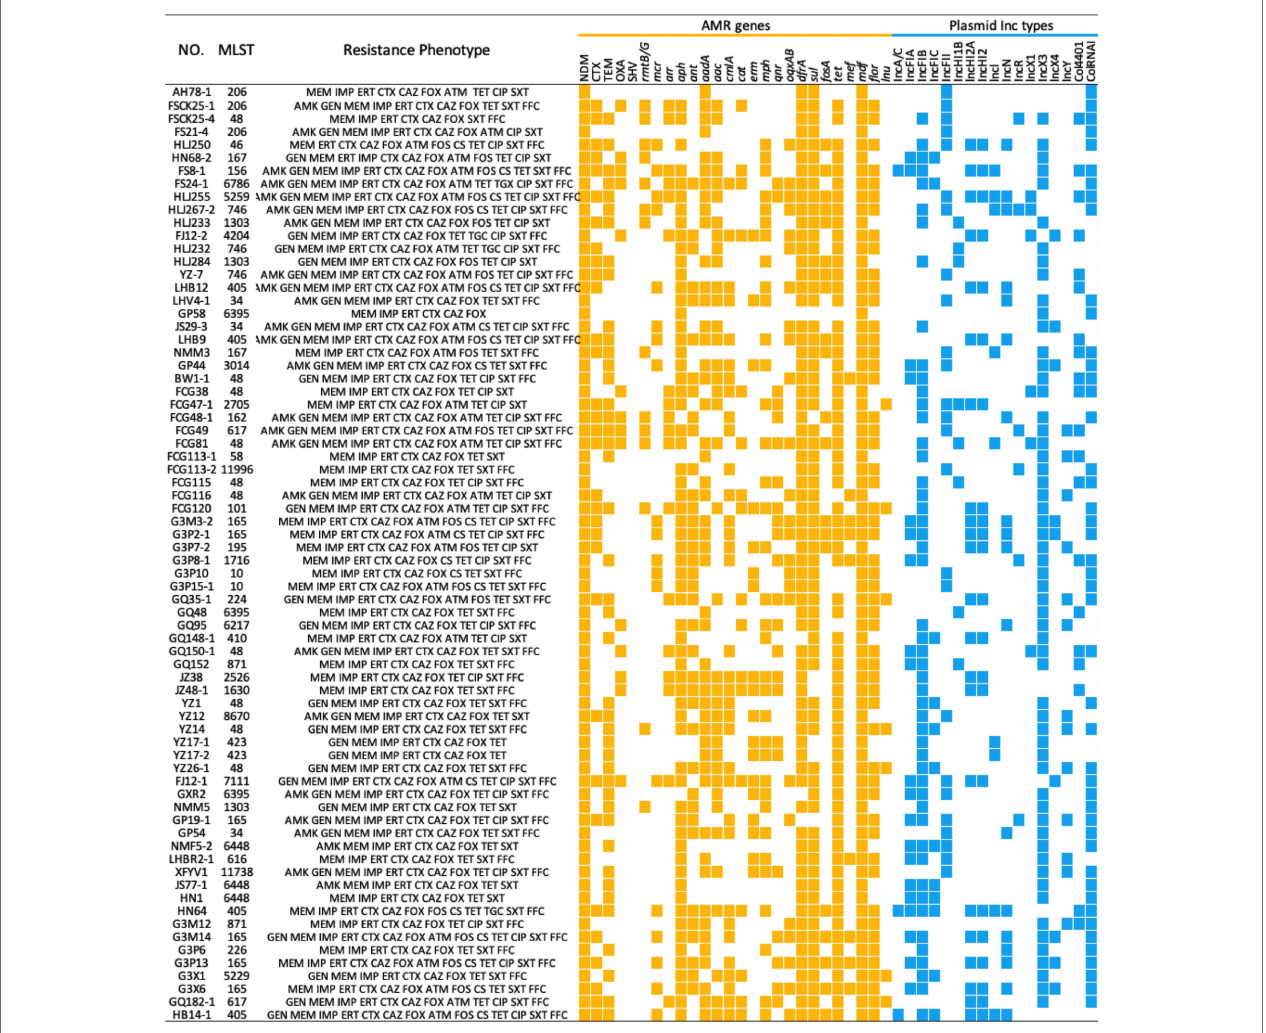
FIGURE 2 | MLST, Resistance Phenotype, ARG and plasmid replicons of 72 NDM-positive Escherichia coli isolates from food-producing animals in China. The heatmap was generated after aligning the contigs of sequenced genomes of each strain to MLST, Resfinder and PlasmidFinder. ARGs and plasmid Inc. types are indicated by yellow and blue squares, respectively. AMK, amikacin; GEN, gentamicin; MEM, meropenem; IMP, imipenem; ERT, ertapenem; CTX, cefotaxime; CAZ, ceftazidime; FOX, cefoxitin; ATM, aztreonam; FOS, fosfomycin; CS, colistin; TET, tetracycline; TGC, tigecycline; CIP, ciprofloxacin; SXT, sulfamethoxazole- trimethoprim. FFC,